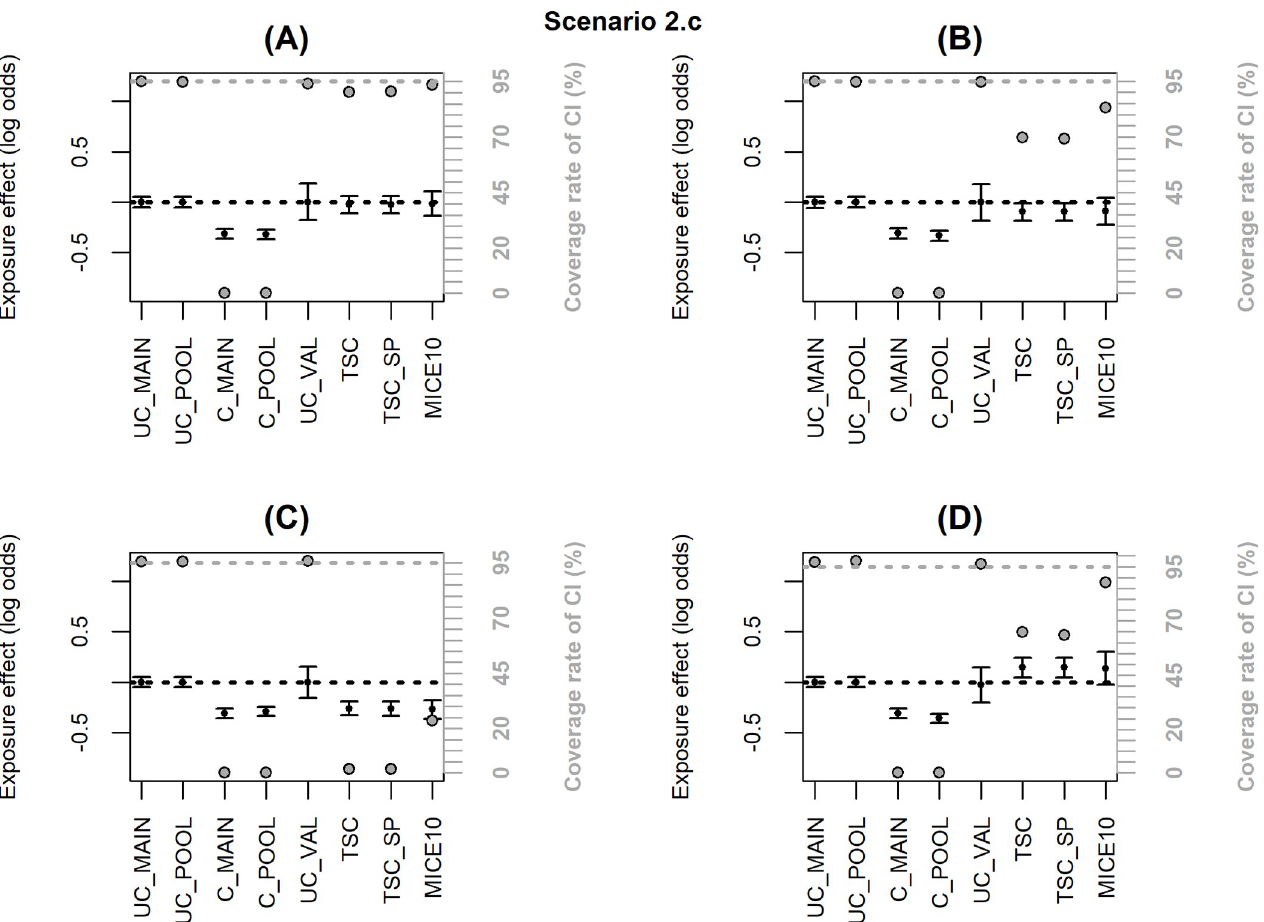
Fig 6. Simulation results when the inclusion probability in the external validation sample (notated P) depends on U 1 ; coverage rate of 95% confidence interval (grey dot with black margin) and mean estimated log-odds ratio for the exposure effect (black dot) ± empirical standard error: (A) logit(P) = -2.2 +log(2) U , (B) logit(P) = -2.7+log(4) U , (C) logit(P) = -2.3+log(2) U +log(2) X � U , (D) logit(P) = -2.5+log(2) U +log(2) Y � U . The grey dotted line corresponds 1 1 1 1 1 1 to the nominal value of the coverage rate of the 95% confidence interval. The black dotted line is the true value of β (0).